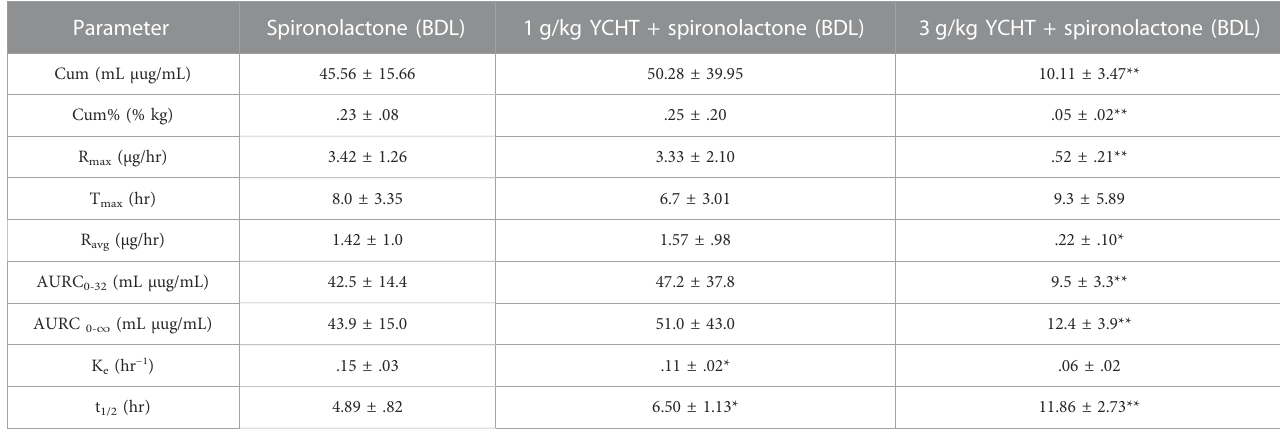
TABLE 4 Urinary pharmacokinetic parameters of canrenone after oral administration of spironolactone in bile duct-ligated rats. Parameter